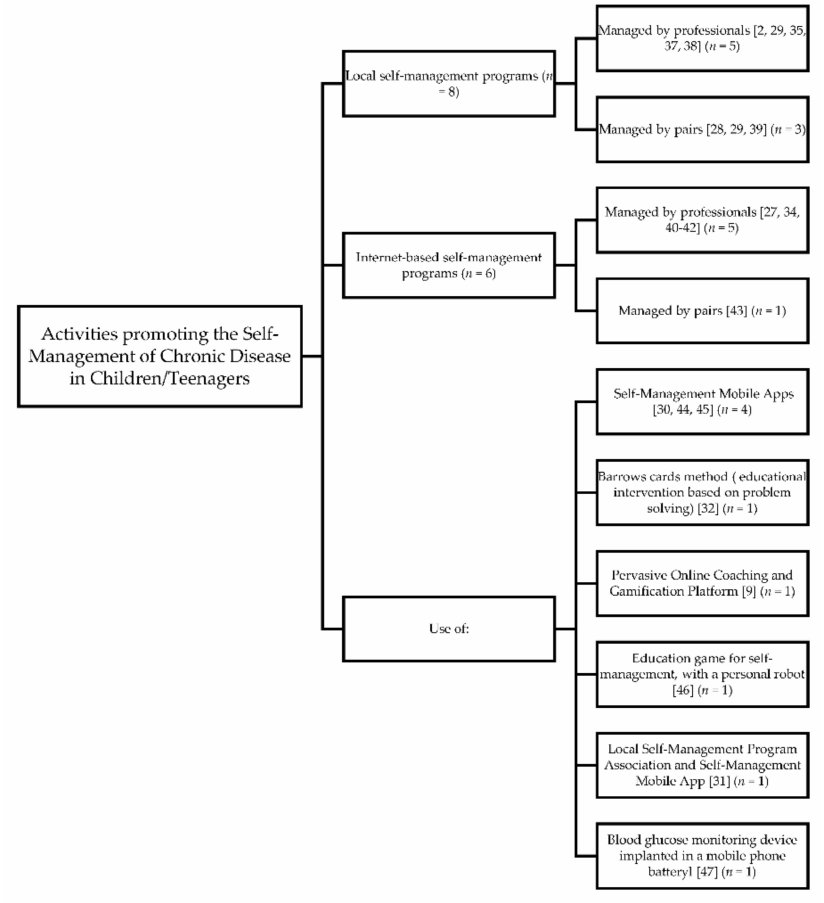
Scheme 2. Activities related to the intervention to promote self-management of children